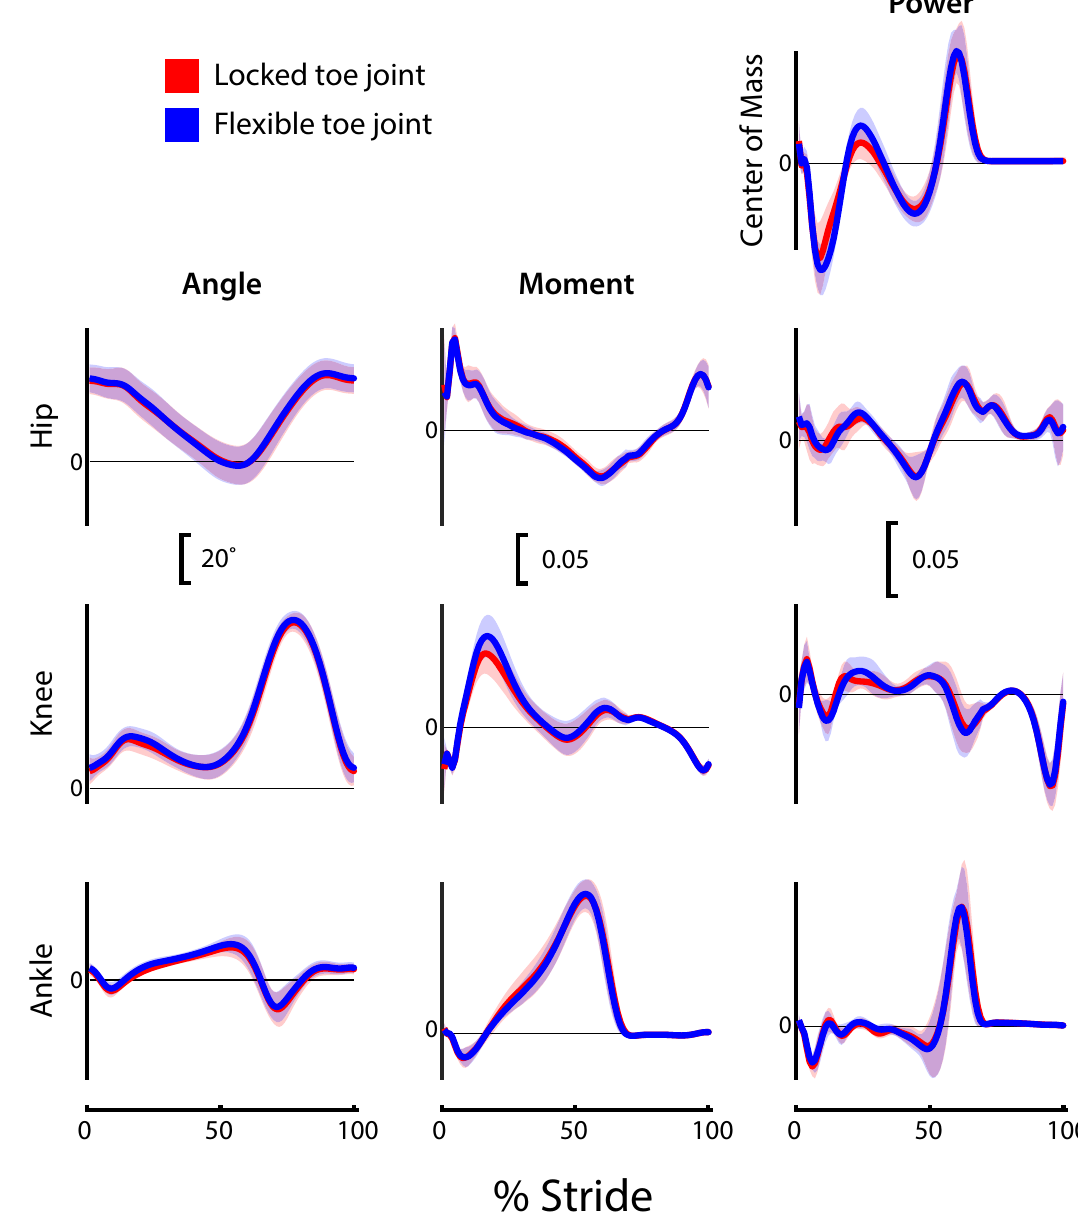
Figure 2. Intact limb (non-prosthetic) joint and center of mass dynamics for participants ( N = 9) walking in a passive prosthesis with (i) a Flexible (dark blue line) and (ii) a Locked (light red line) toe joint configuration. Kinematic (angles) and kinetic (moments, powers) data were cropped into strides using ipsilateral heel strikes of the intact limb. Data presented as mean ± standard deviation (shaded regions). Using group mean re-dimensionalization constants, 0.05 corresponds to 0.47 Nm kg −1 for moments, and 1.50 W kg −1 for Joint kinetics. Most kinetic profiles were unaltered by the transition between Locked and Flexible toe joint configuration (Figs. 2 and 3). In fact, for all but the intact limb knee moment, prosthesis power, and center of mass powers, the group mean plots were visually indistinguishable. Positive prosthesis work during Push- Off was reduced in the Flexible configuration (0.018 ± 0.007 dimensionless, or 16.0 J) compared to the Locked configuration (0.021 ± 0.007 dimensionless, or 18.7 J; p = 0.004; Fig. 3). On average this decrease in prosthesis Push-Off work was 16% but ranged from 3 to 31% across our participant sample. The reduction in Push-Off also appeared in whole-body center of mass power (0.037 ± 0.023 dimensionless in the Flexible configuration versus 0.040 ± 0.023 dimensionless in the Locked configuration; p = 0.039; Fig. 3). Gross rate of oxygen consumption. No significant differences in gross rate of oxygen consumption were found between the Flexible-Locked-Flexible trials (p = 0.097; Fig. 4A). The initial Flexible test incurred